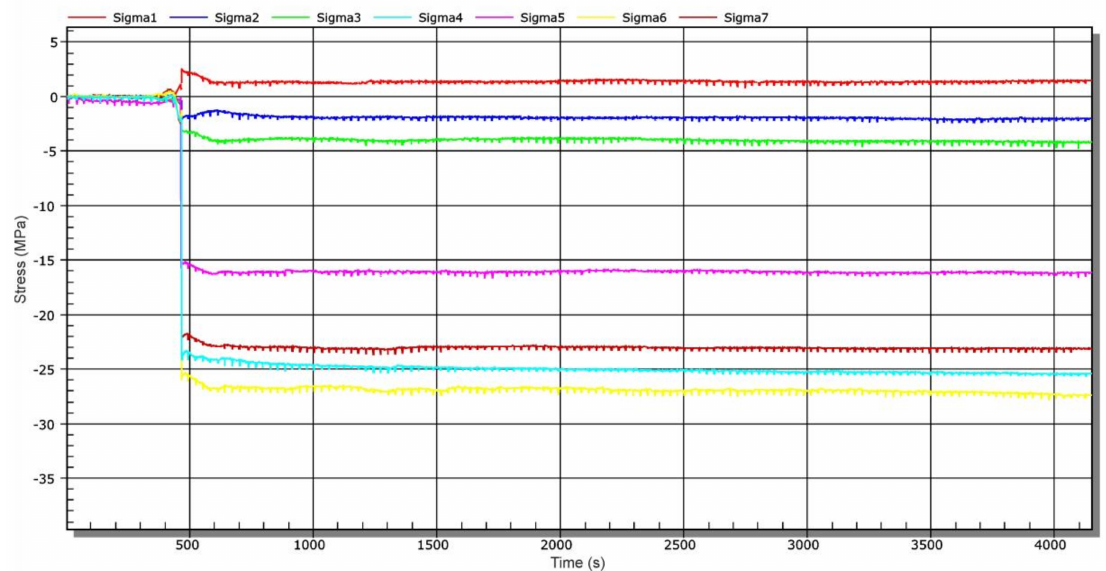
Figure 14. Time-dependent stress chart during water discharge from the water tunnel—stage